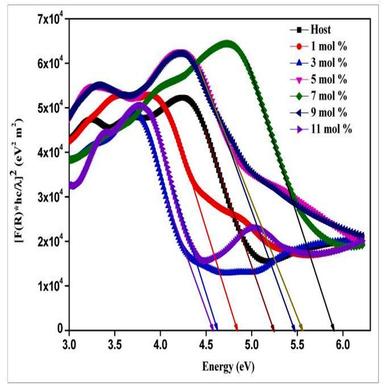
K-M plot of Sr2MgSi2O7:Dy3þ NPs.